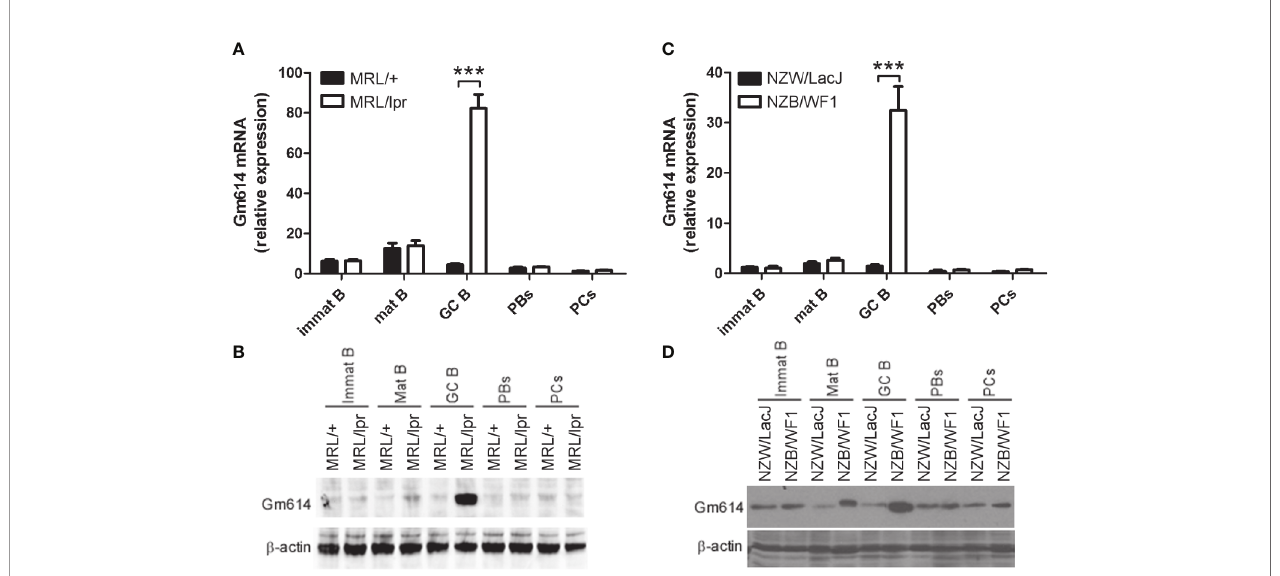
FIGURE 1 | Gm614 was highly expressed in germinal center (GC) B cells from lupus-prone mice. Immature B cells (Immat B), mature B cells (Mat B), GC B cells, plasmablasts (PBs), and plasma cells (PCs) from splenocytes of six lupus-prone MRL/lpr mice and their control MRL/+ mice (A, B) or lupus-prone NZB/WF1 mice and their control NZW/LacJ mice (C, D) were sorted by fl ow cytometry (FACS), and subjected to qPCR (A, C) and western blot (B, D) analysis. (A – D) Data represent three independent experiments. (A, C) Two-Way ANOVA were followed by Bonferroni post-tests (n = 6), Error bars, s.e.m., ***p <